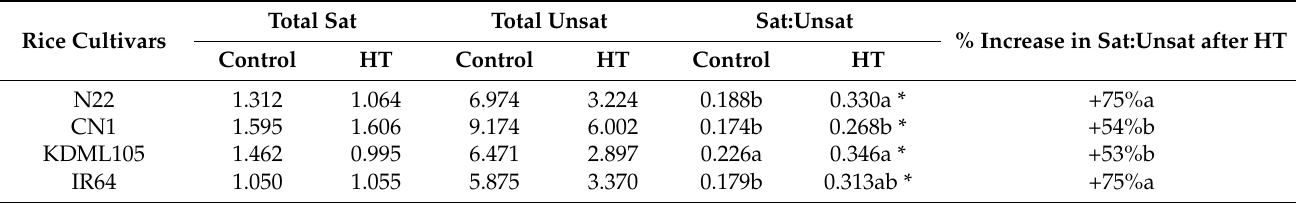
Table 3. Ratio of saturated and unsaturated fatty acids in different seedling rice cultivars (N22, CN1, KDML105 and IR64) after exposure to high temperature at 42 ◦ C for 7